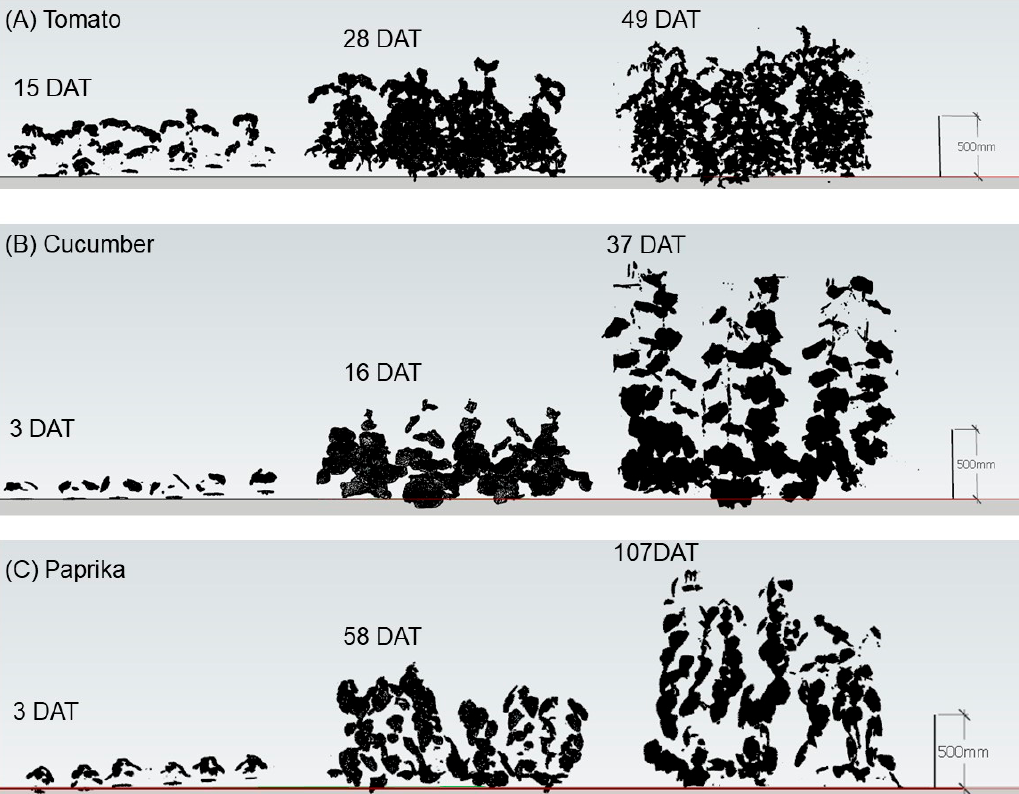
Figure 4. Surface model of plant canopies for estimation of LAI and plant structure. Tomato canopies were scanned using the 3D scanner (DPI-8X, Opt Technologies Co., Ltd., Tokyo, Japan) from 5 April to 23 May 2019 (15–63 days after transplanting (DAT)) ( A ). Cucumber canopies were scanned from 3 April to 23 May 2019 (1–51 DAT) ( B ). Paprika canopies were scanned from 5 April to 2 August 2019 (3–122 DAT) ( C ). Plant canopy surface models were constructed using SketchUp 2017 (Trimble Inc., Sunnyvale, CA, USA). LAI, leaf area index.